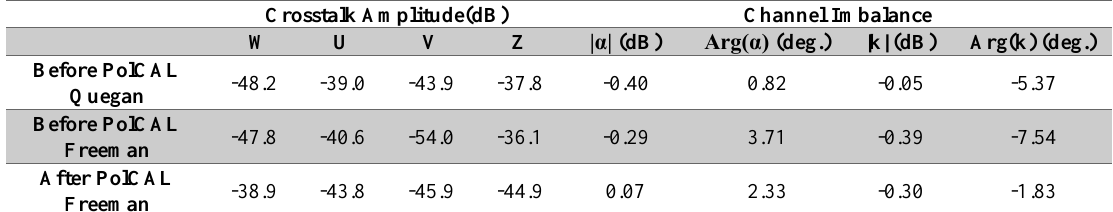
Table 3. Polarization errors before and after